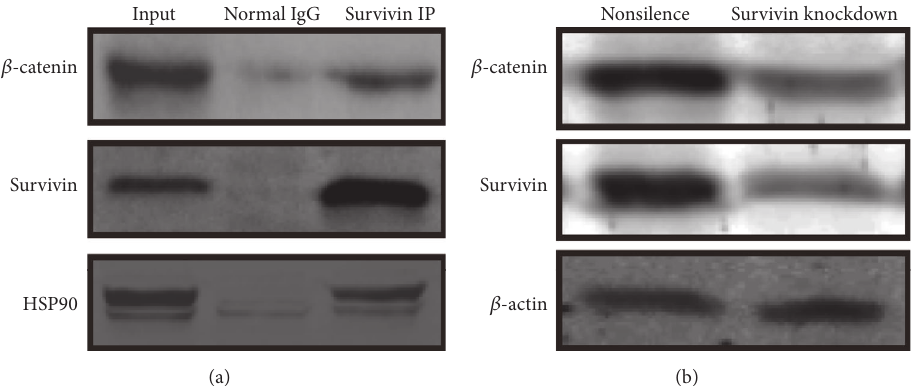
Figure 6: ChIP (chromatin immunoprecipitation) analysis of Survivin in ES (iPS) cells. (a) ChIP of 𝛽 -catenin and Survivin promoter. HSP90 (hot shock protein 90) was the positive control. (b) Survivin-RNAi (knockdown) made 𝛽 -catenin reducing expression by the analysis of Western blot.